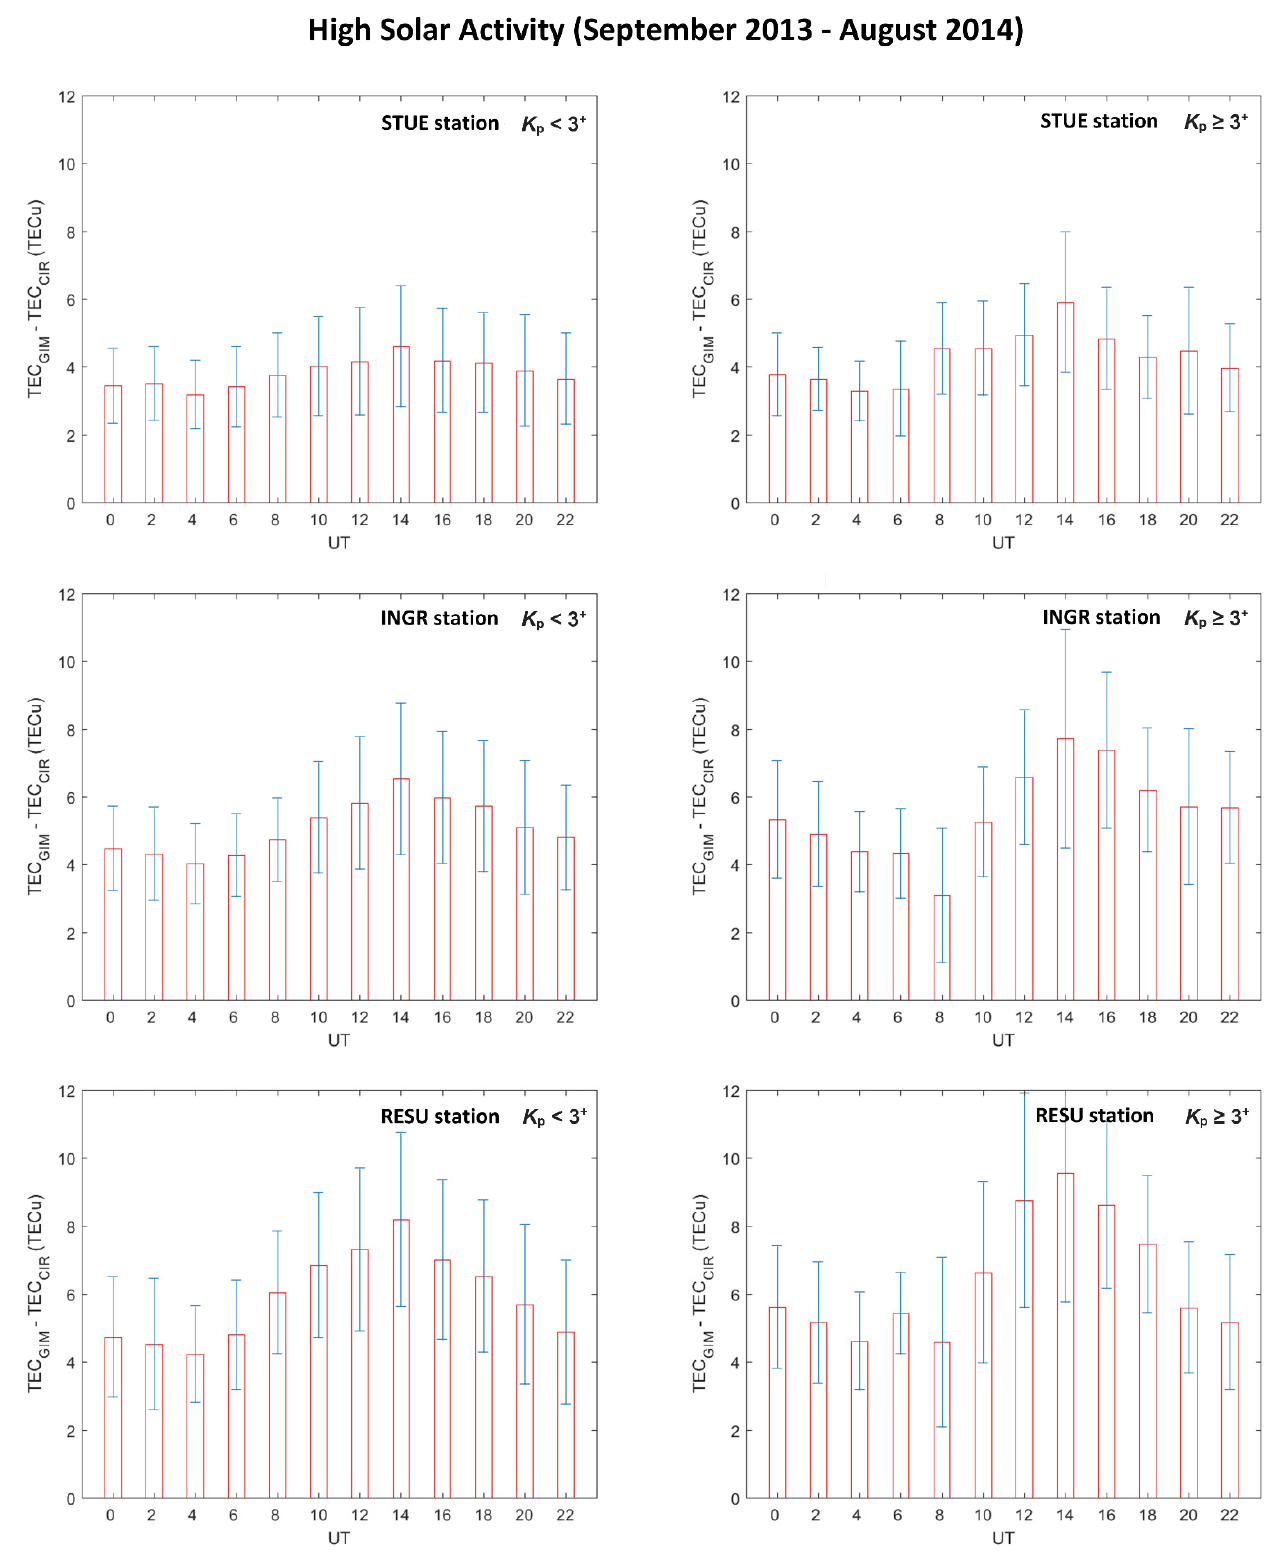
Figure 7. Daily variation of the difference (TEC GIM - TEC CIR ) in terms of hourly mean and corresponding standard deviation, with a time resolution of 2 h (corresponding with the time resolution of GIMs), for STUE (upper row), INGR (middle row) and RESU (lower row) for the HSA period between September 2013 and August 2014. Left panels refer to quiet geomagnetic values ( K p < 3 + ), while right panels refer to disturbed geomagnetic values ( K p ≥ 3 + ).